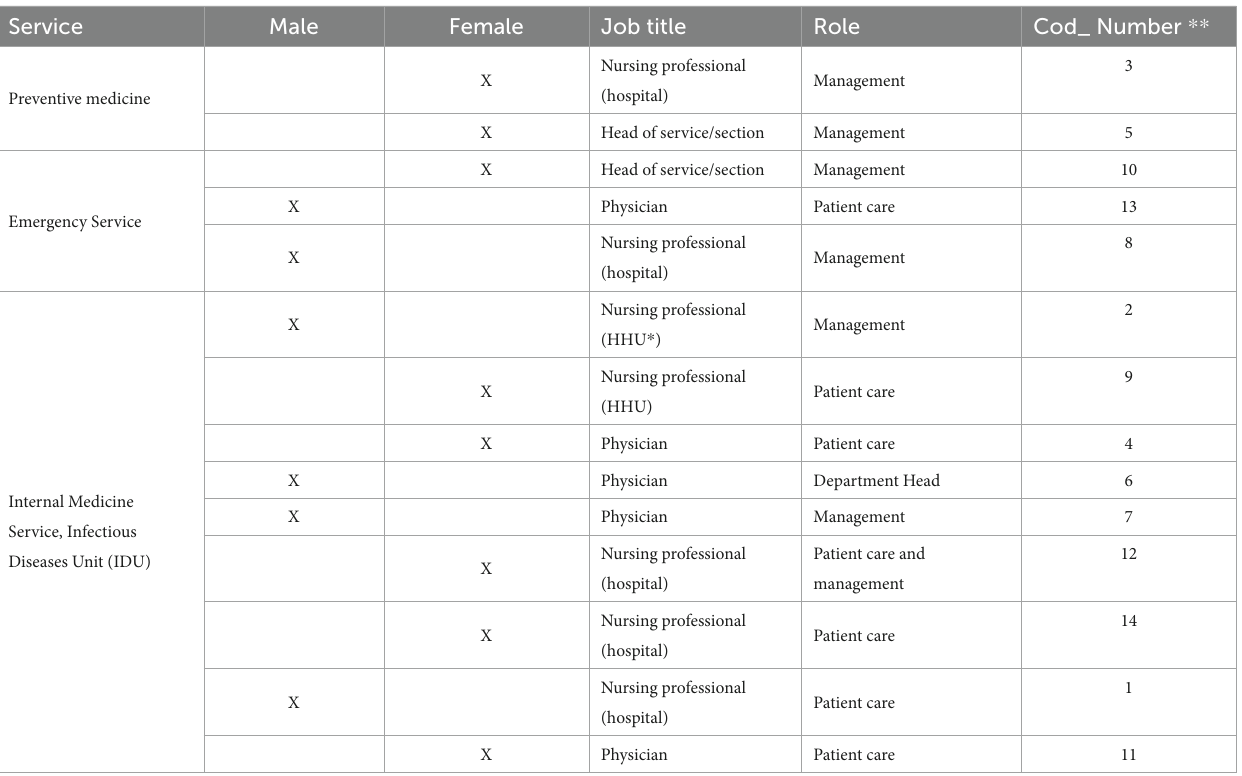
TABLE 2 Job profile characteristics of the